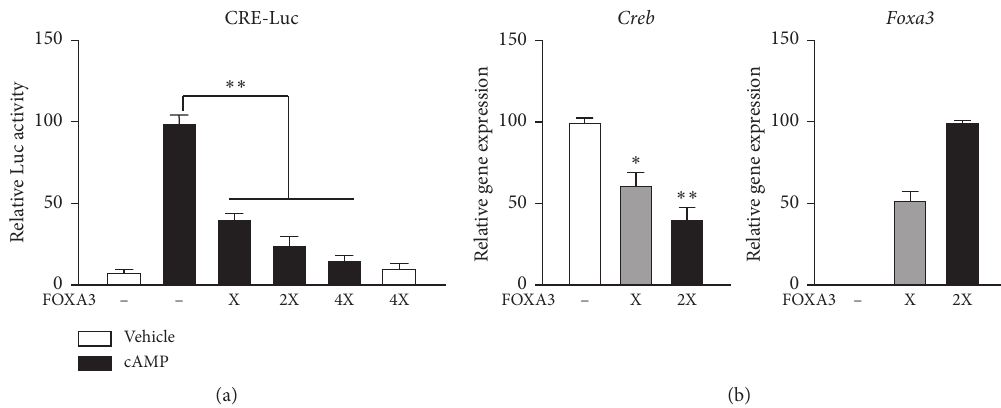
Figure 3: FOXA3 represses cAMP-induced CREB transactivation and expression in MA-10 cells. FOXA3 strongly inhibits cAMP-induced CREB transactivation of a CRE-dependent promoter in MA-10 cells. Cells were transfected with a CRE-Luc reporter, SV-40 β -gal, and indicated concentration of FOXA3 (X represents 100ng of the expression construct) for 48h that included overnight cAMP induction (200 μ M). Luciferase activity was normalized to β -galactosidase activity (A). FOXA3 represses CREB expression in MA-10 cells. Foxa3 and Creb expression were quantified using qRT-PCR. The gene expression level was normalized to that of GAPDH . Cells were transfected with indicated concentrations of FOXA3 (X represents 200ng of the expression construct) for 48h that included cAMP induction (200 μ M) for 4h (B). Statistical significance was assessed using the t -test. ∗ P < 0 . 001; ∗∗ P < 0 . 0001.